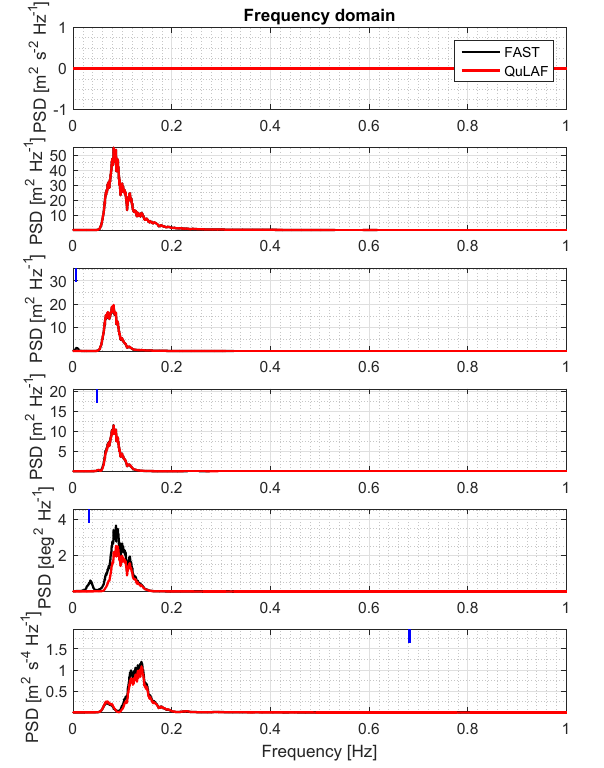
natural frequency. Heave is dominated by the wave forcing, and the response of both models agree well. In pitch, res- onance with the natural frequency also exists in both mod- els, although QuLAF predicts more energy at that frequency than FAST. Both surge and pitch responses are resonant, thus they are especially sensitive to the amount of damping. The overprediction of pitch motion also leaves a footprint on the PSD of nacelle acceleration, which shows energy at the pitch natural frequency, the wave frequency range and the tower natural frequency. The level of excitation of the tower mode at 0.682 Hz, however, is slightly underpredicted by QuLAF, likely due to an overestimation of the aerodynamic damping on the tower